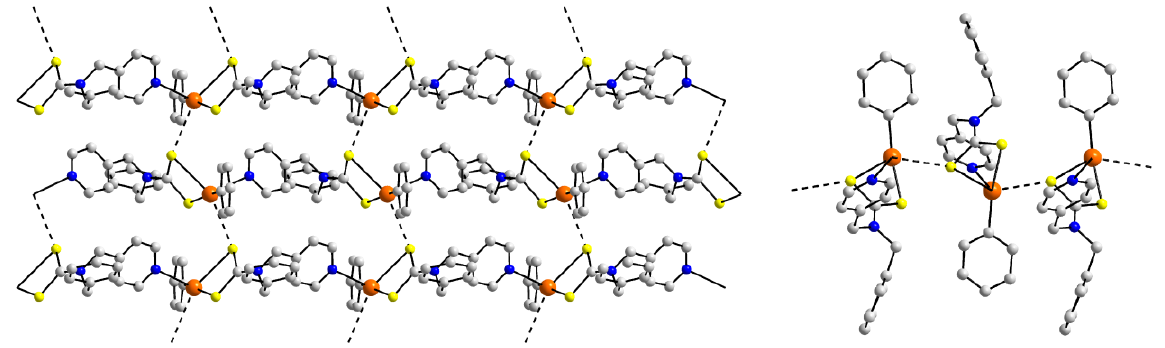
Figure 17. Views of the two-dimensional array in the crystal of [PhHg(L 8 )] n ( 52